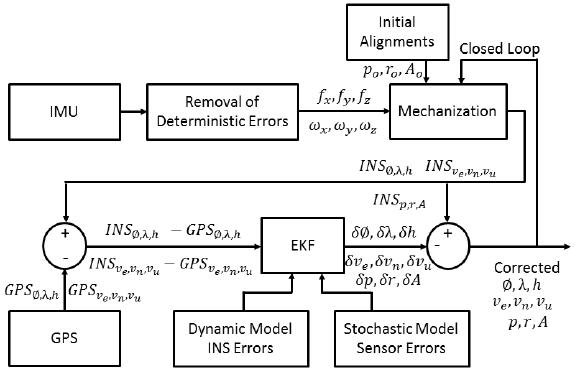
Figure 4. Closed loop loosely coupled integration